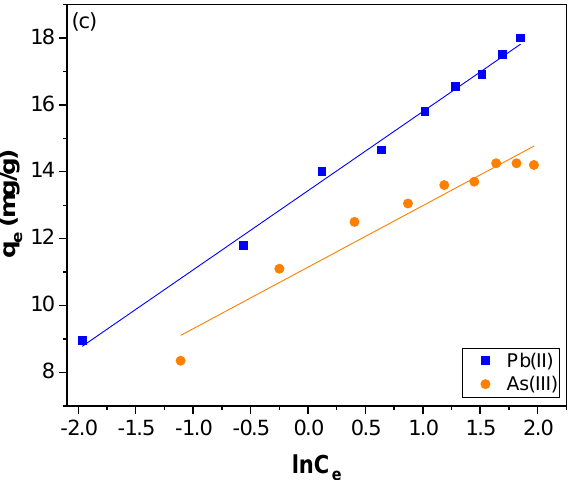
Figure 10. ( a ) Langmuir, ( b ) Freundlich, and ( c ) Temkin isotherms for Pb(II) and As(III) adsorption over CNTs – PAMAM – Ag. Table 2. Parameters calculated from Langmuir, Freundlich, and Temkin adsorption isotherms. Langmuir Isotherm Freundlich Isotherm Temkin Adsorbate